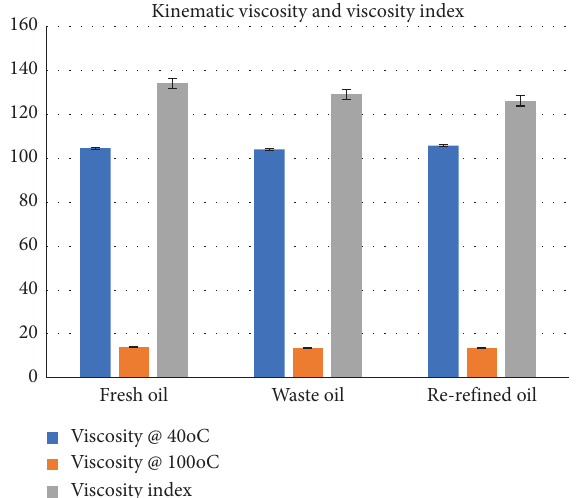
Figure 5: Kinematic viscosity and kinematic viscosity index of oil